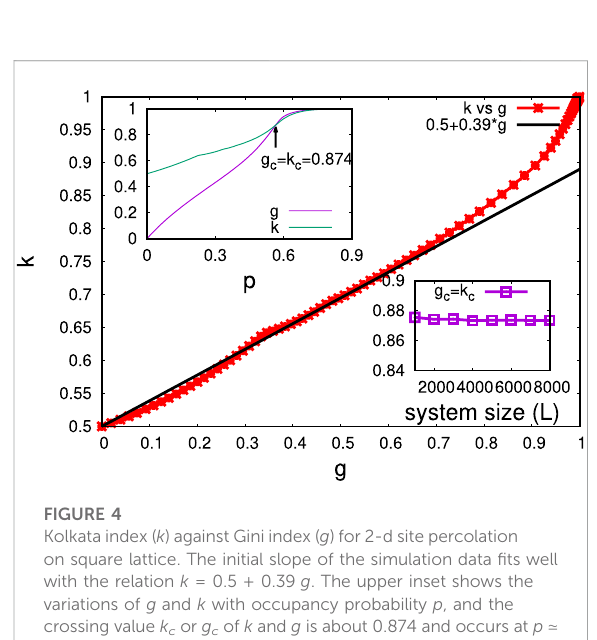
FIGURE 4 Kolkata index ( k )against Gini index ( g )for 2-d site percolation on square lattice. The initial slope of the simulation data fi ts well with the relation k = 0.5 + 0.39 g . The upper inset shows the variations of g and k with occupancy probability p , and the crossing value k c or g c of k and g is about 0.874 and occurs at p ≃ 0.565, somewhat below p c ≃